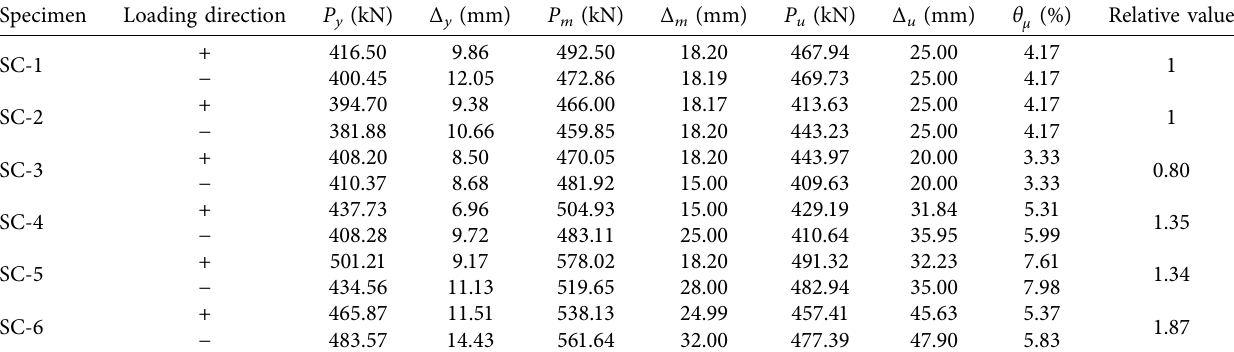
Table 5: Experimentally derived characteristic loads and displacements for specimens SC-1 through SC-6. Specimen